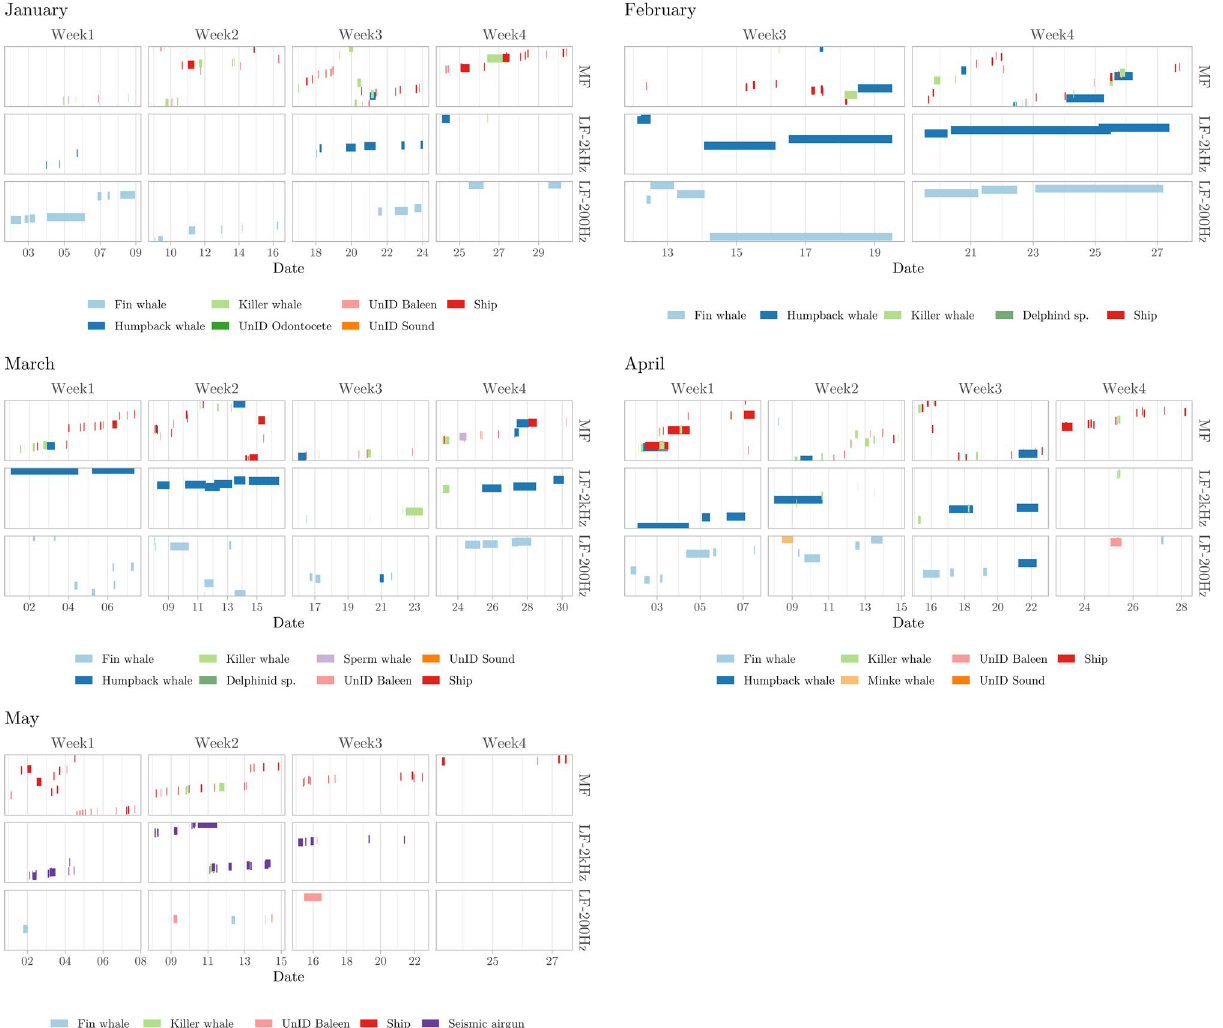
Figure 6. Overview of detection events for each week of each month and detection band (LF-200 Hz refers to frequencies between 0 and 200 Hz, LF-2 kHz refers to frequencies between 200 Hz and 2 kHz, and MF refers to frequencies above 2 kHz). The y axis represents the order in which the data were processed. Segment length indicates event